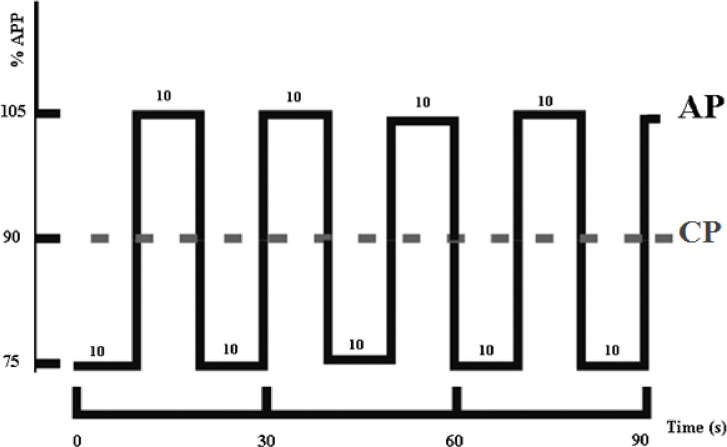
Experimental protocol; CP: Continuous protocol; AP: Alternated protocol.